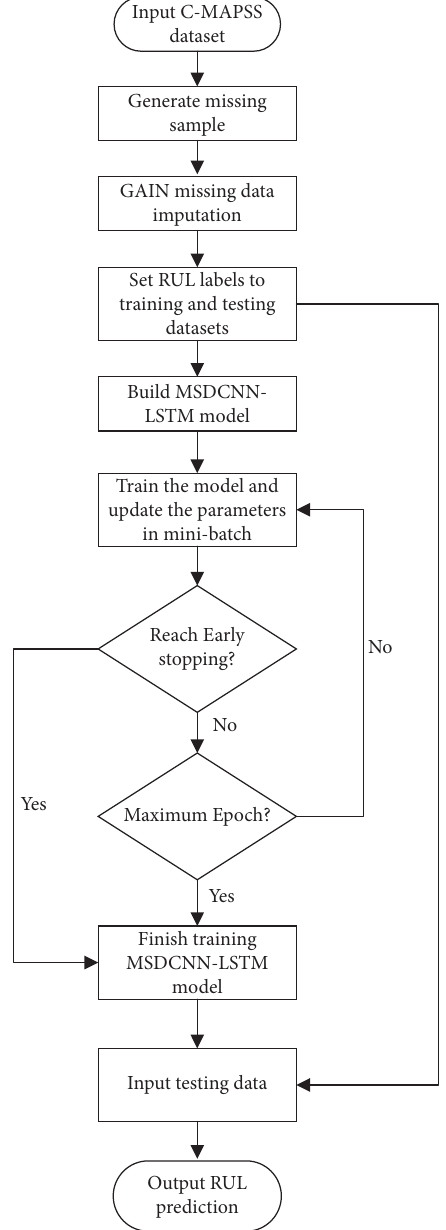
Figure 4: Flowchart of the RUL prediction.